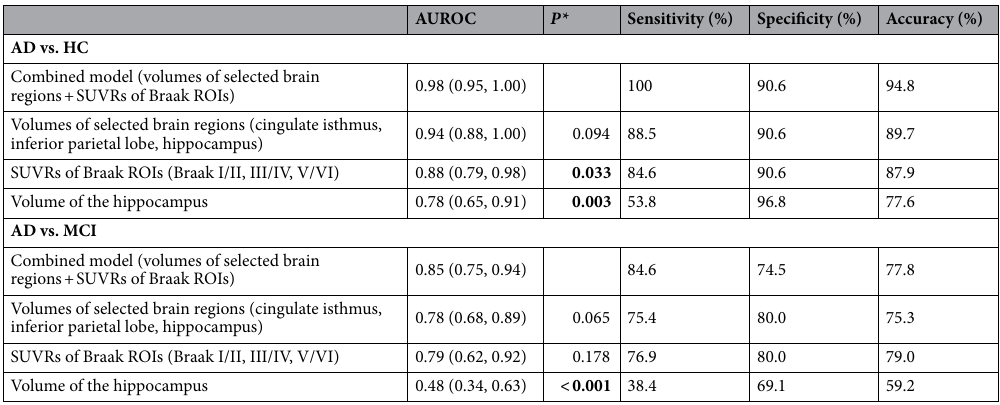
Table 3. Comparison of combined and individual performance using volumes of selected brain regions, SUVRs of Braak ROIs and volume of the hippocampus in discriminating AD from HC and MCI. Numbers in parentheses are 95% confidence intervals. AUROC = area under the receiver operating characteristics curve. P < 0.05 values are indicated in bold * P -value refers to the significance between the differences of the AUROCs between the combined model and other